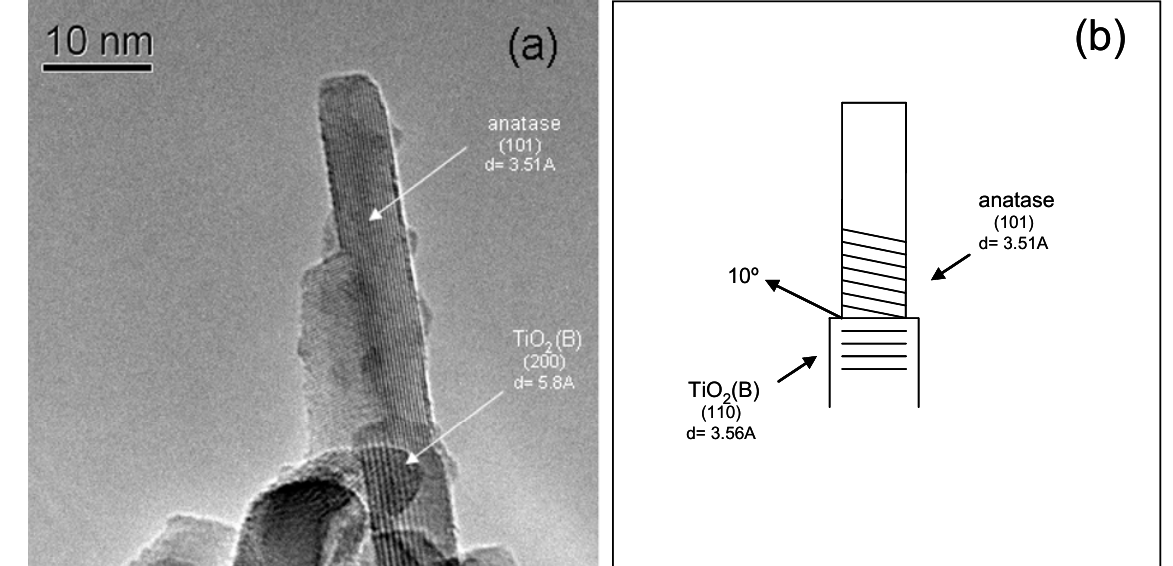
Figure 10. (a) HRTEM image illustrating a remained untransformed TiO representation of the position and relationship between (011) planes of anatase and (110) planes of TiO